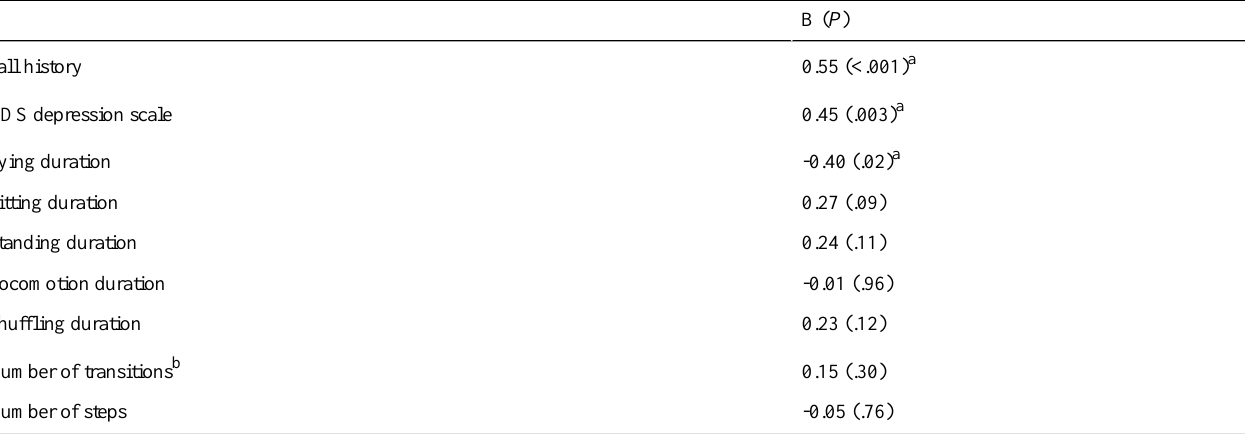
Table 3. Univariate logistic regression of questionnaire parameters and amounts of physical activities with future falls (B values [ P values] are based on z -transformed data).